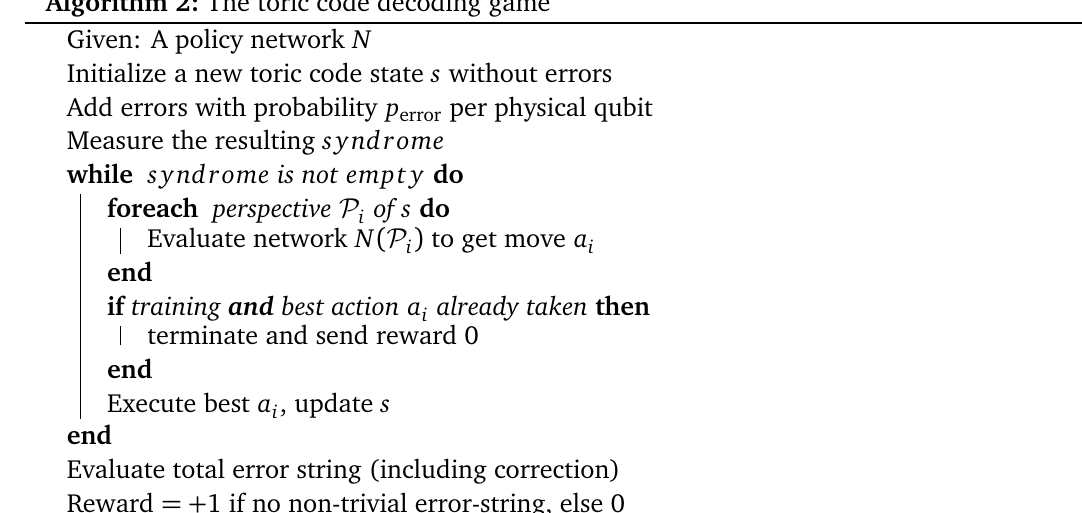
Algorithm 2: The toric code decoding